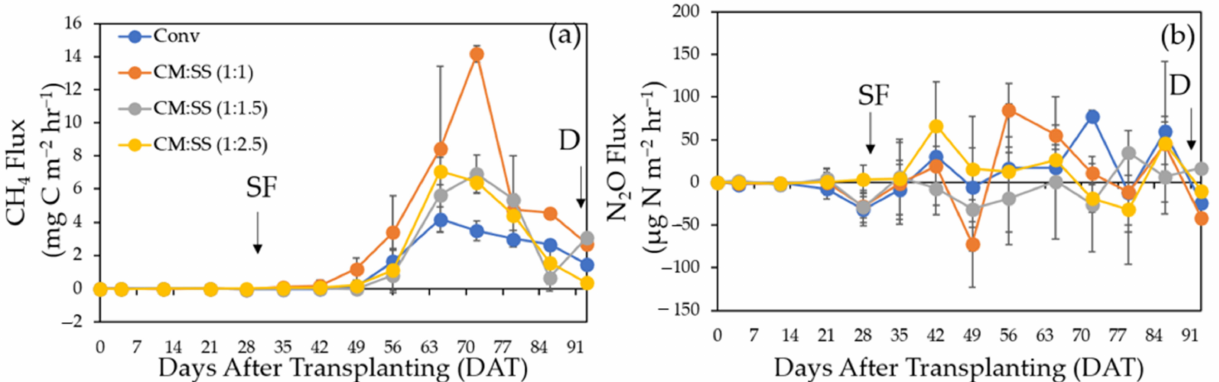
Figure 3. CH 4 flux ( a ) and N 2 O flux ( b ) in each treatment during the pot experiment. All values are expressed as means. Conv: conventional, CM: chicken manure, SS: steel slag, SF: supplementary fertilization, D: time when the pot was dried. Error bars represent standard error.